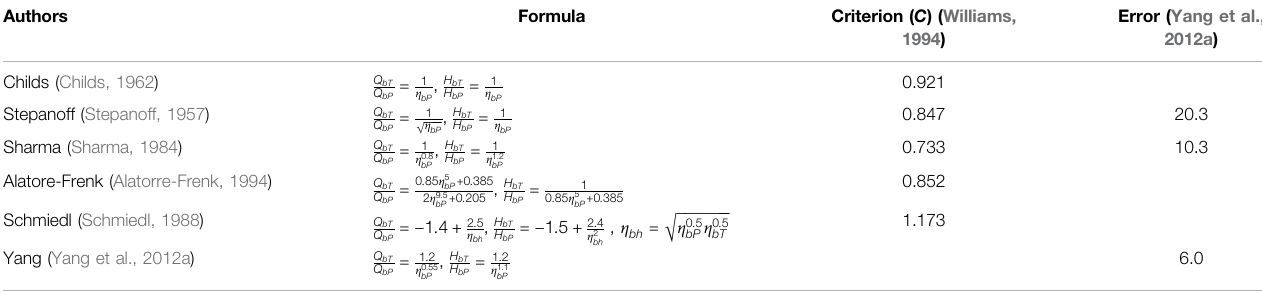
TABLE 1 | PAT performance prediction methods using BEP.